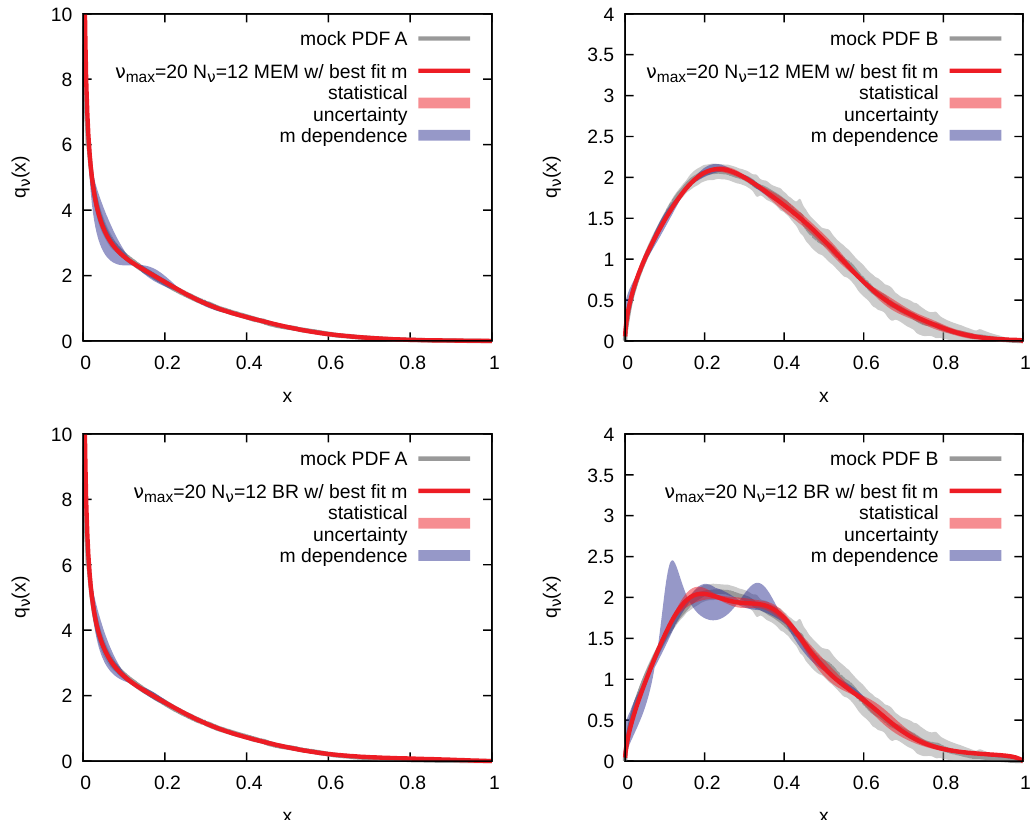
Figure 16 . x -space PDF’s reconstructed using the Maximum Entopy Method (top) as well as the Bayesian reconstruction (BR) method (bottom) from N (cid:23) = 12 Io(cid:11)e-time data points on the interval (cid:23) = [0 ;